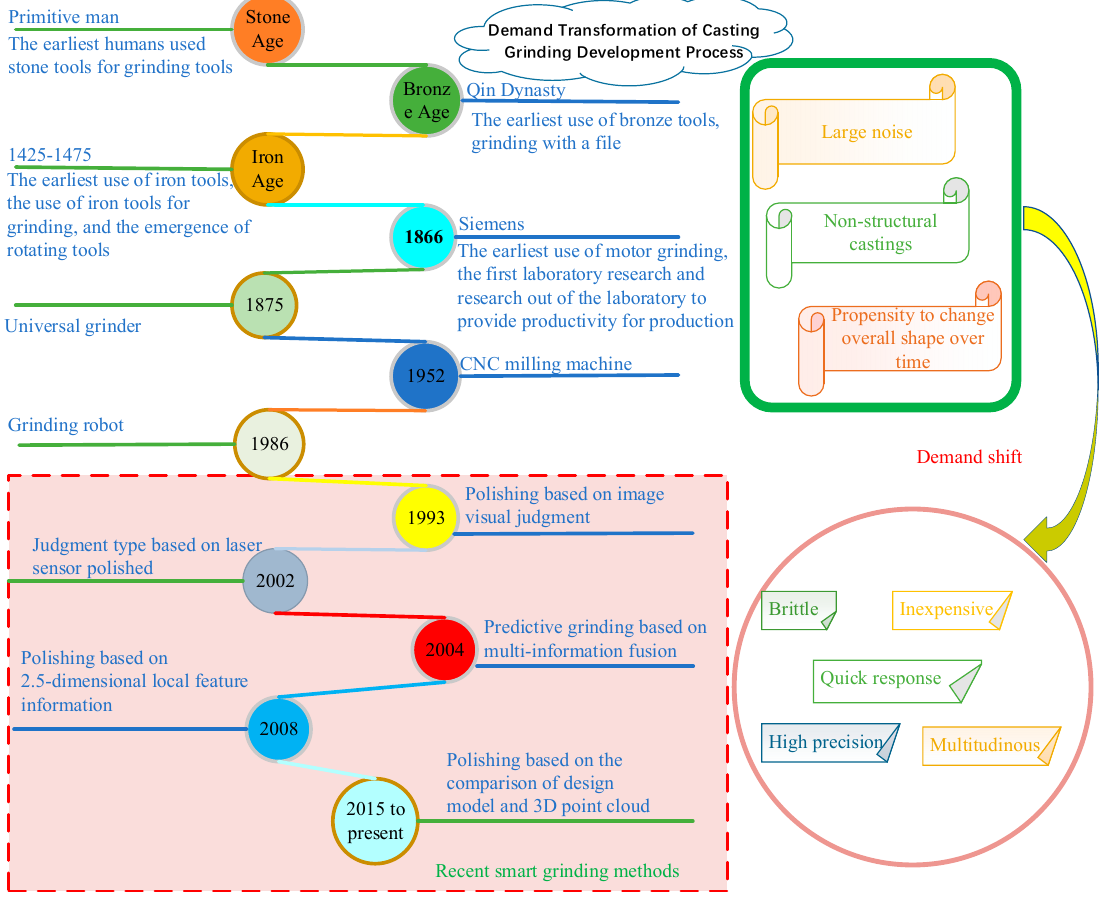
Table 2. Comparison of grinding methods.